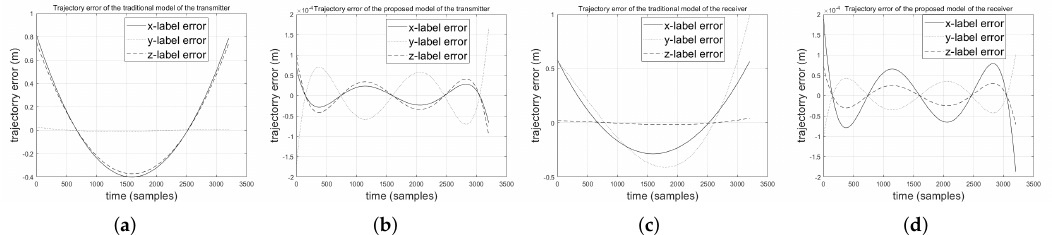
Figure 2. Calculation results of trajectory errors. ( a ) Trajectory error of the traditional model of the transmitter. ( b ) Trajectory error of the extended model of the transmitter. ( c ) Trajectory error of the traditional model of the receiver. ( d ) Trajectory error of the extended model of the receiver. The errors of the extended model are smaller than λ